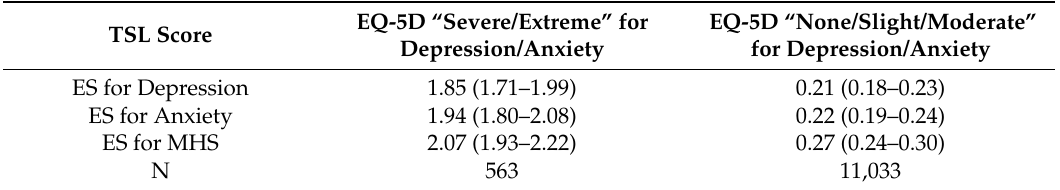
Table 5. Effect Sizes (ES) * for Targeted Symptoms List (TSL) Levels of Depression, Anxiety and Mental Health